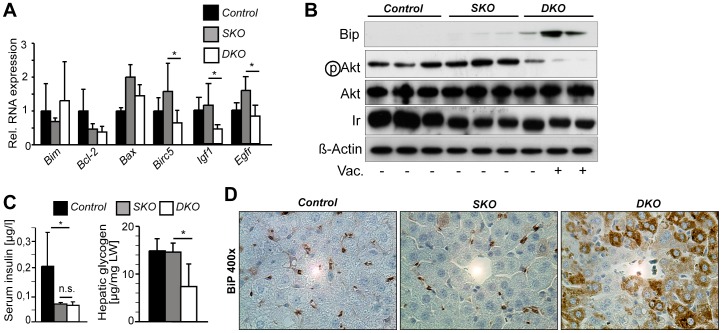
Loss of c-Jun affects the expression of genes related to growth factor signaling and Akt.(A) Hepatic expression of the indicated genes at 6 days upon Cre induction was determined by qPCR and is given as relative expression compared to control livers (n = 5 livers/genotype); *, P≤0.05. (B) Expression of the indicated proteins in total liver lysates of mice with the indicated genotypes was determined by immunoblotting. Ir, Insulin receptor. β-Actin was used as control. Samples from livers with strongly increased hepatocyte vacuolization are indicated. (C) Hepatic glycogen content and serum insulin concentrations were analyzed 6 days after Cre induction (n = 4–11/genotype); *, P≤0.05. (D) BiP expression predominantly occurred in vacuolated hepatocytes in DKO mice as determined by immunohistochemistry.